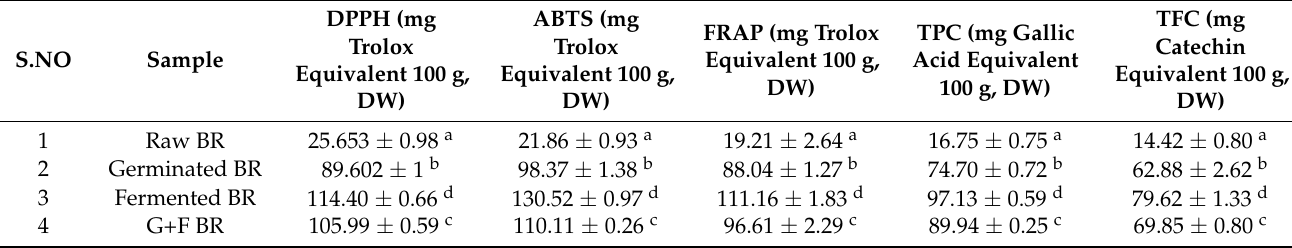
Table 1. Total antioxidants, DPPH, ABTS and FRAP, total phenolic content (TPC) and total flavonoid content (TFC) of different rice